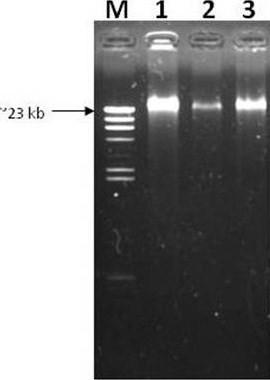
Total DNA isolation of L. lactis subsp. lactis M4. Lane M: λ/HindIII marker (Fermentas); Lanes 1 to 3: L. lactis M4.